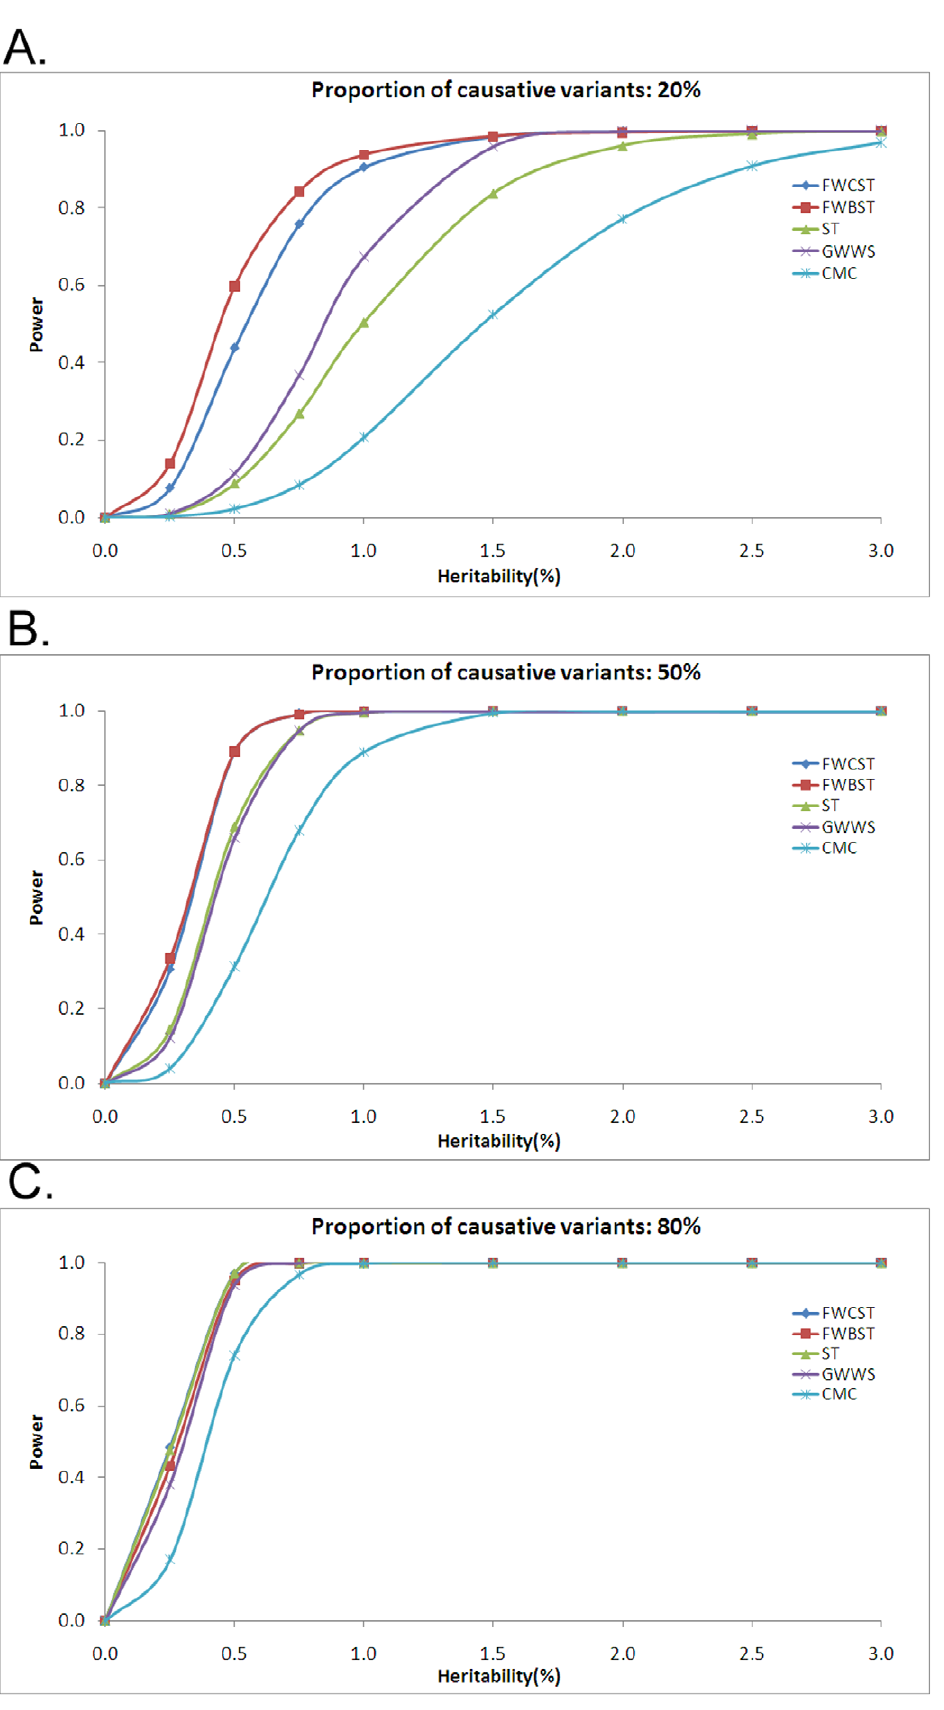
Figure 9. Power with gene effect. Locus heritability varies from 0% to 3%. See the legend for figure 4 for abbreviations and simulation detail. doi:10.1371/journal.pone.0013857.g009 PLoS ONE |